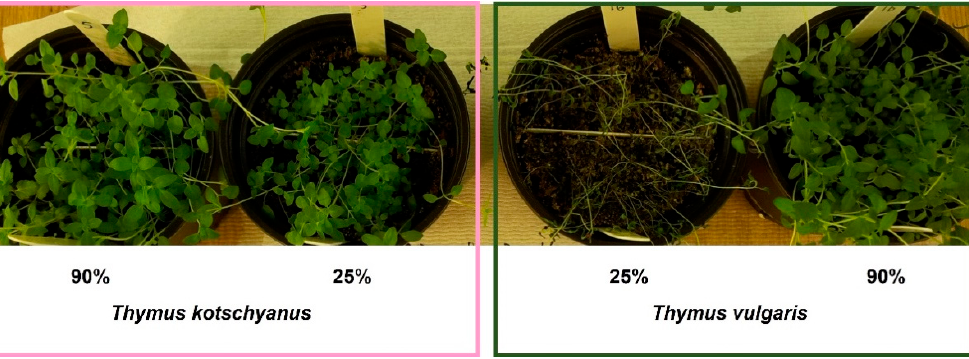
Figure 1. Crops of Thymus kotschyanus ( left ) and Thymus vulgaris ( right ) in two different irrigation conditions: normal irrigation (90%) and severe water stress (25%). These two examples show the greater sensitivity of T. vulgaris to water stress compared to T. kotschyanus .